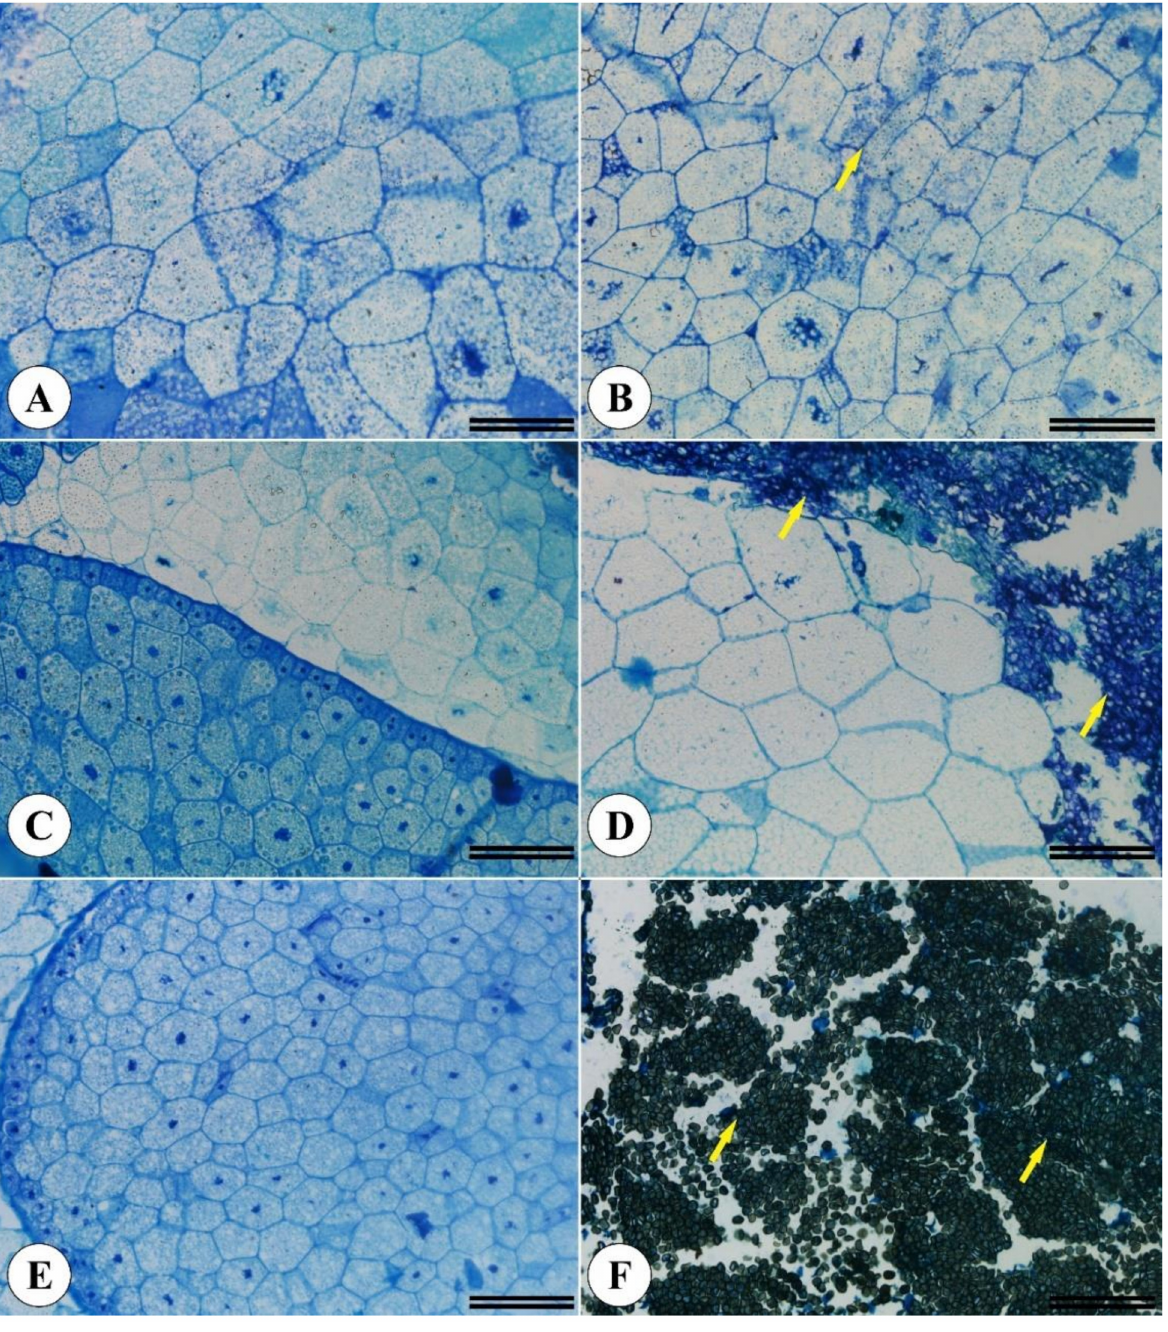
Figure 3. Morphoanatomical Brachiaria brizantha seed structures. Seeds previously selected by the X-ray test displaying no filling alterations ( A , C , E ) and filling alterations ( B , D , F ). ( A , B ) Marandu cv. ( C , D ) Piat ã vc. ( E , F ) Xara é s cv. A total of 200 seeds from each cultivar were analyzed. Yellow arrows indicate cellular